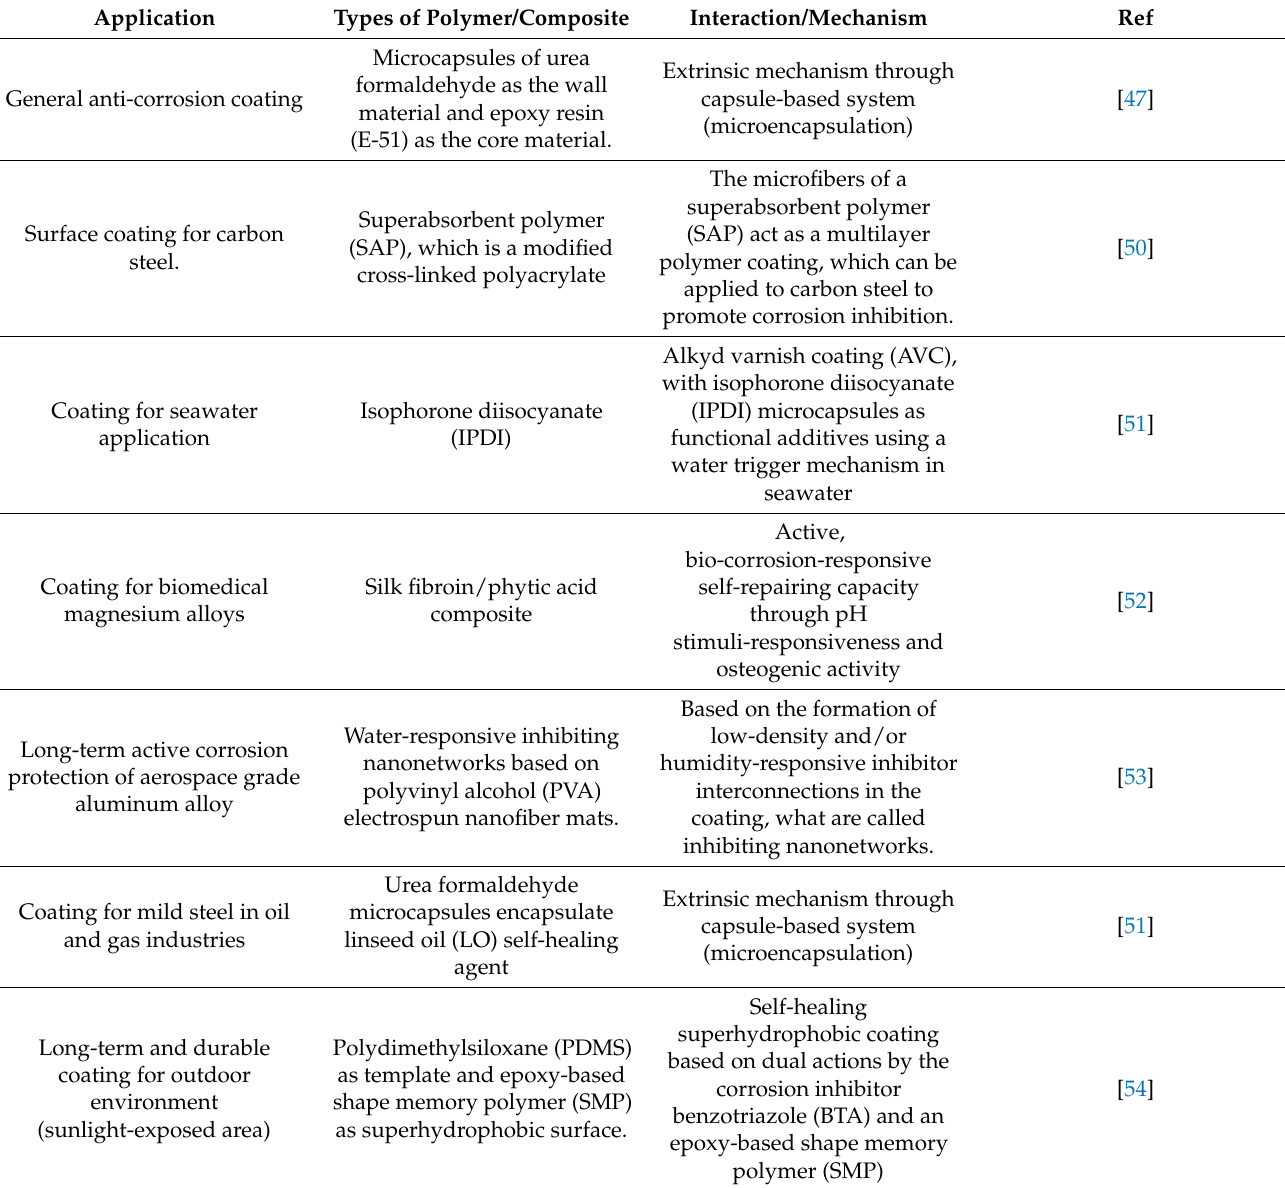
Table 2. Self-healing polymers in coating